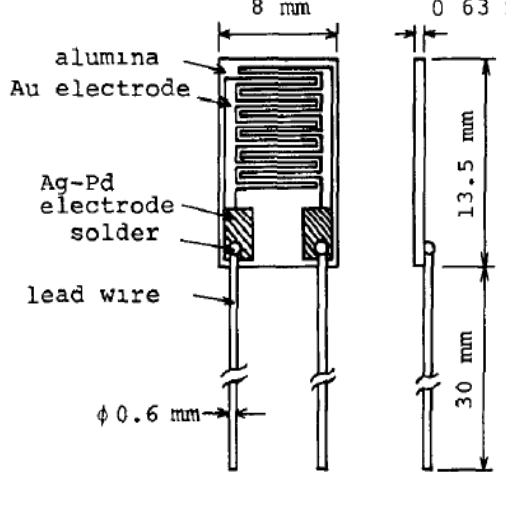
Figure 8. Schematic view of the ‗Hument HPR‘ type humidity sensor